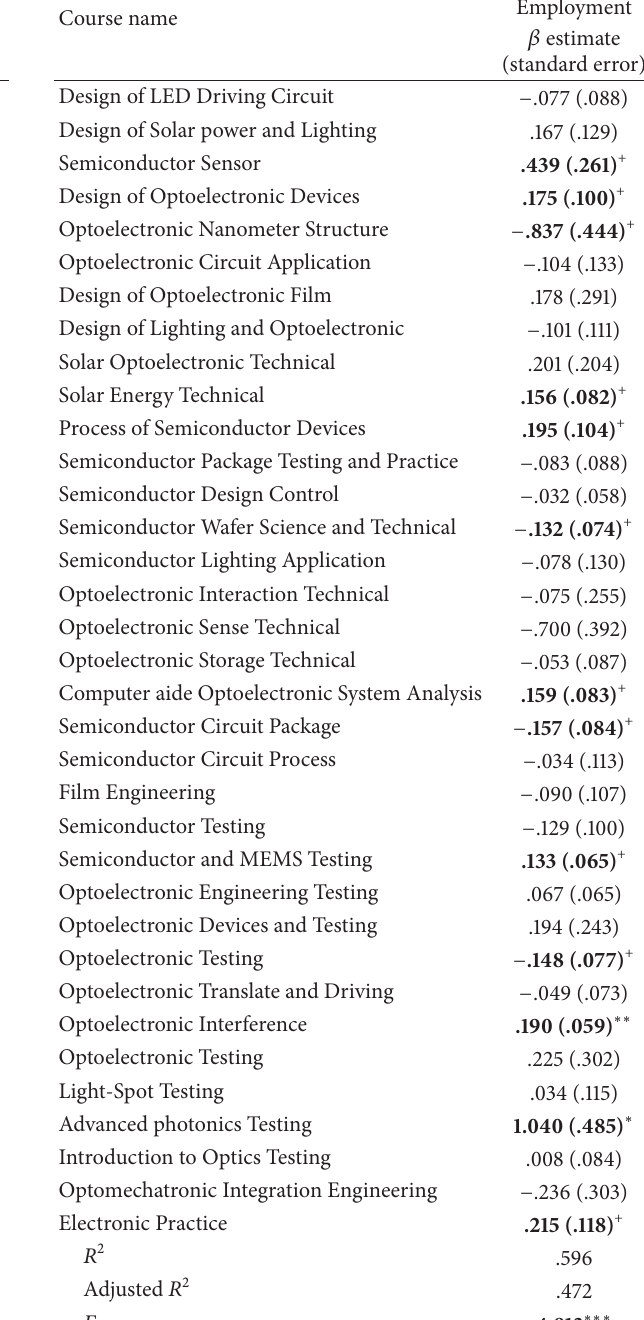
Table 13: Multiple regression analysis—skilled-based domain cur- riculum on employability (industry